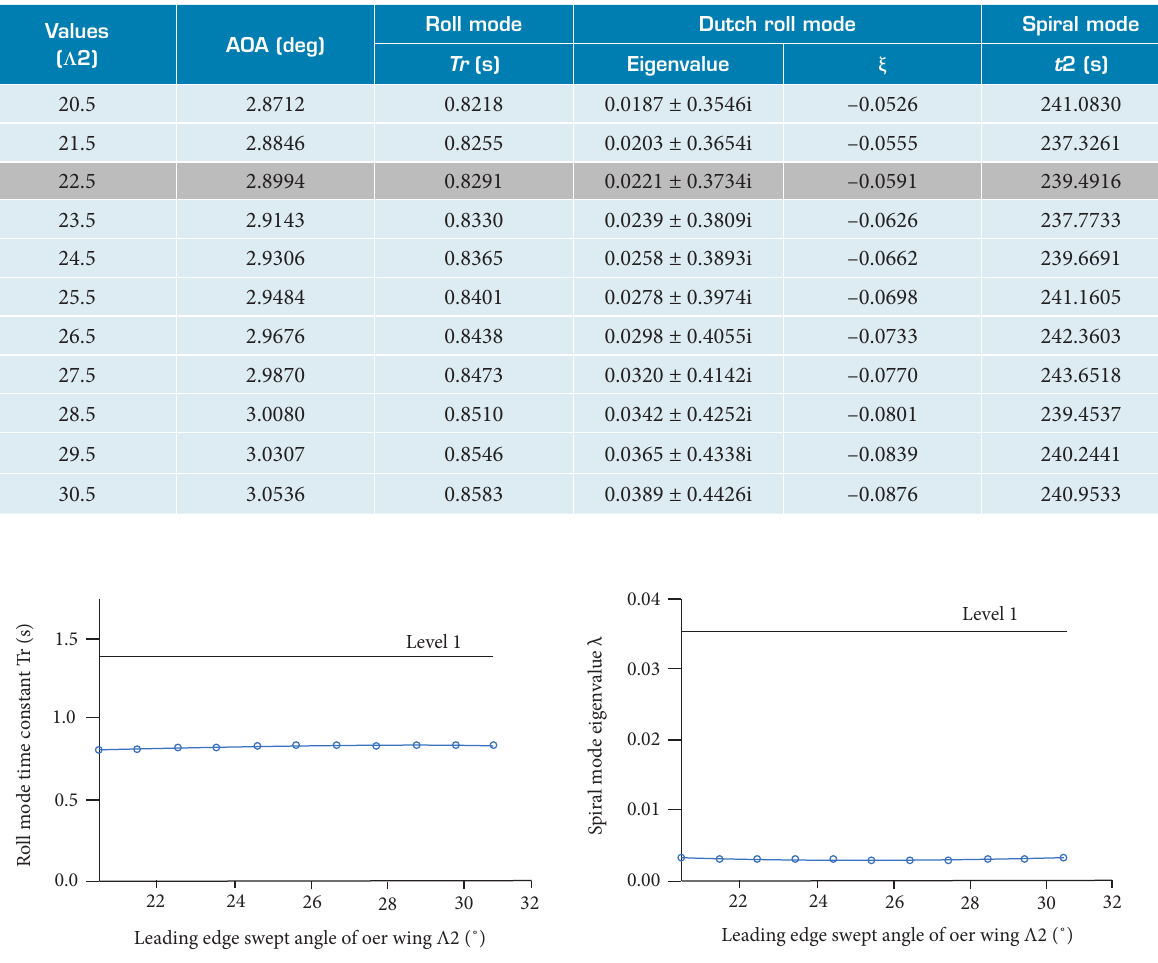
Figure 5. The influence of Λ 1 on roll mode and spiral model. Table 5. Influence of Λ 2 on lateral-directional stability.